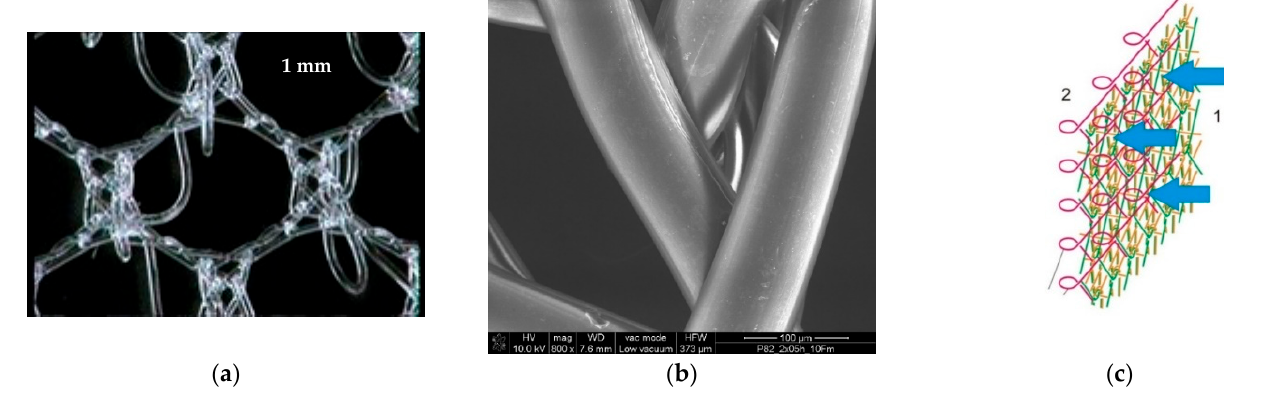
Figure 1. Optical microphotograph ( a ) and SEM microphotograph (mag, 800×) of the designed PACVD-modified prototype of the hernia implant ( b ) used in the study. The idea of PACVD-modification of the designed knitted implants: 1—the flat surface of the implant subjected to PACVD-modification; 2—surface not subjected to the modification with unfolding in the form of protruding loops ( c ) [35].